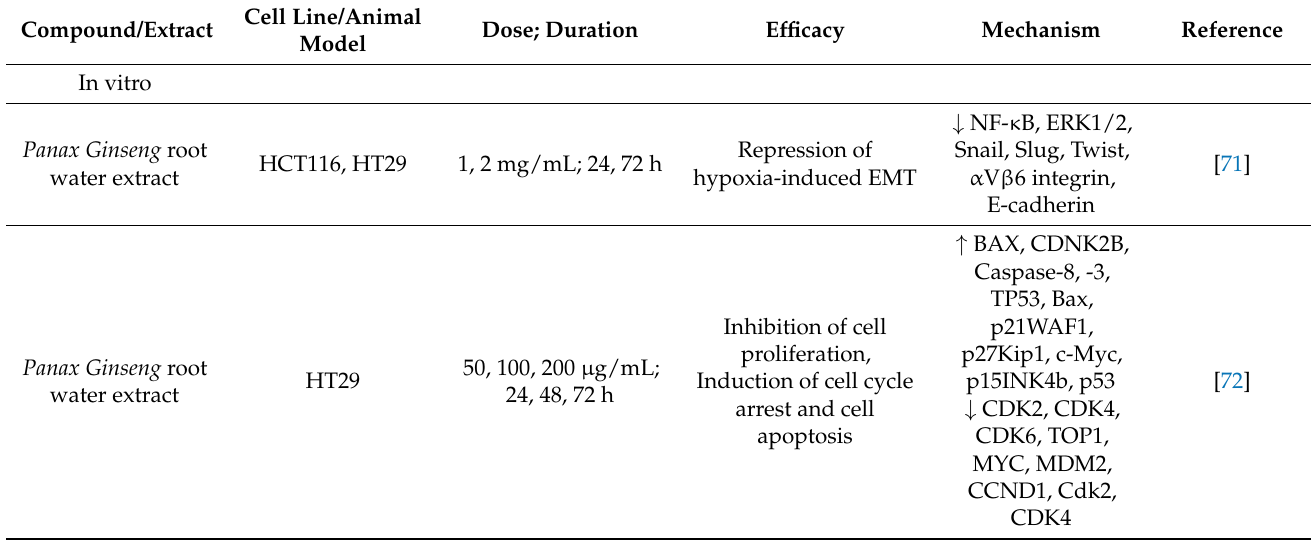
Table 3. Panax ginseng and its metabolites against colon